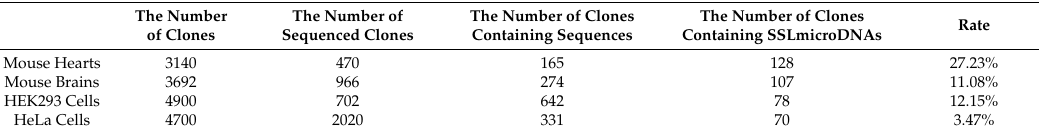
Table 1. Summary of single-stranded microDNA library